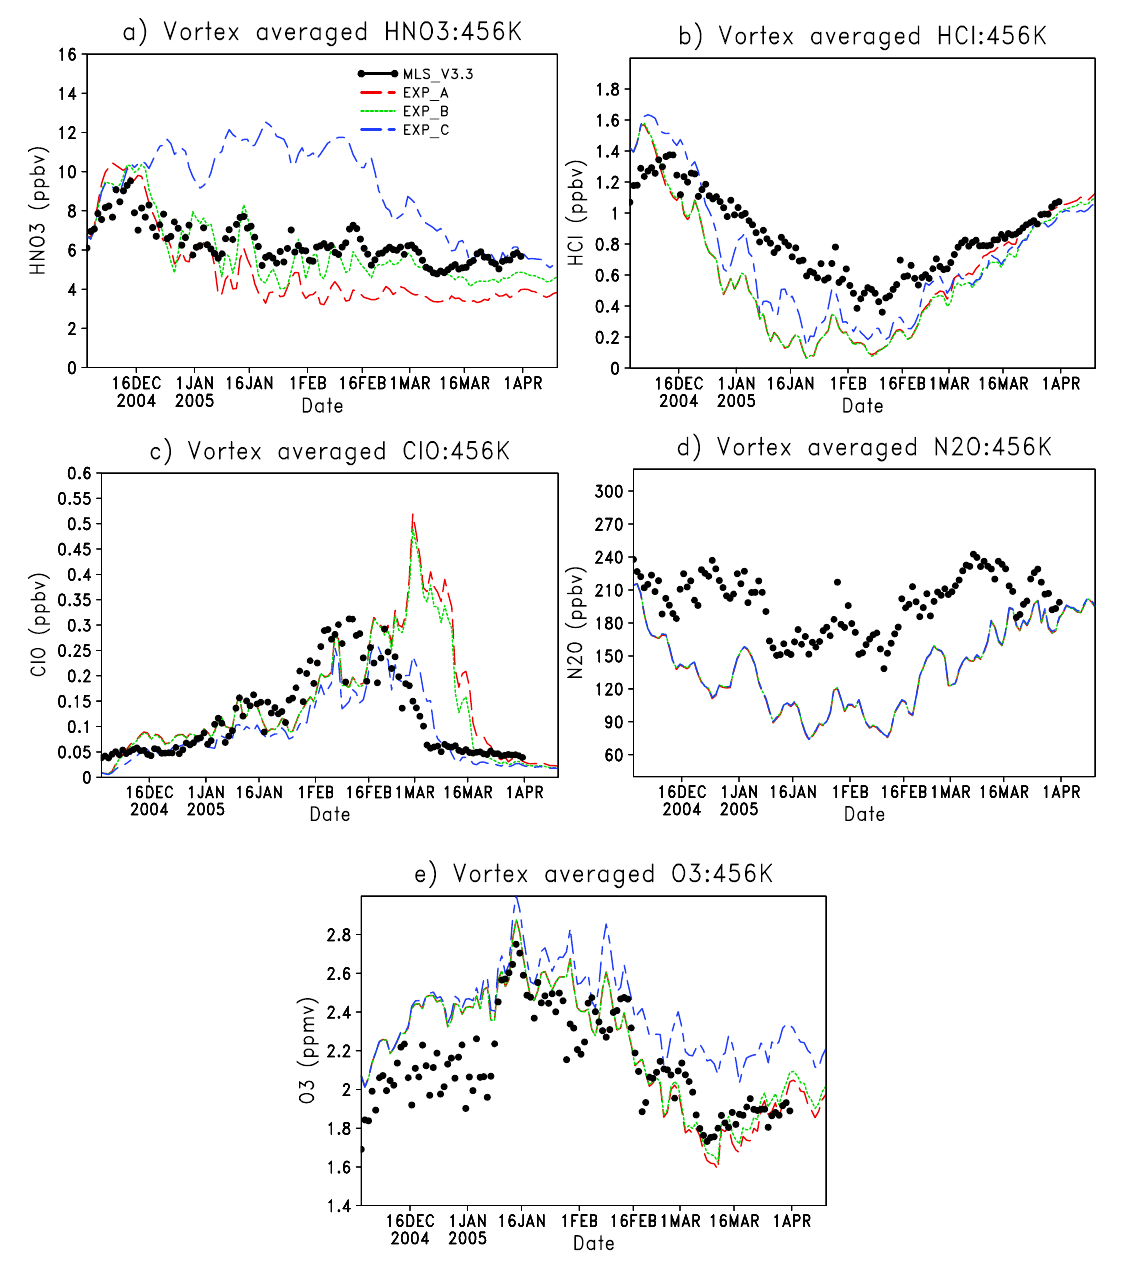
Fig. 4. Time evolution of HNO 3 , HCl, ClO, N 2 O and O 3 from MLS measurements and SLIMCAT simulations using the equilibrium (EXP A) and DLAPSE (EXP B) PSC schemes as well as the simulation without denitrification (EXP C) at 456K ( ∼ 17km).